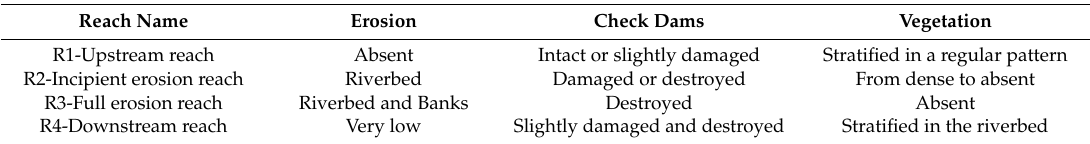
Table 1. Reaches of the Cammarota Stream based on the degree of channel erosion and on the conservation state of check